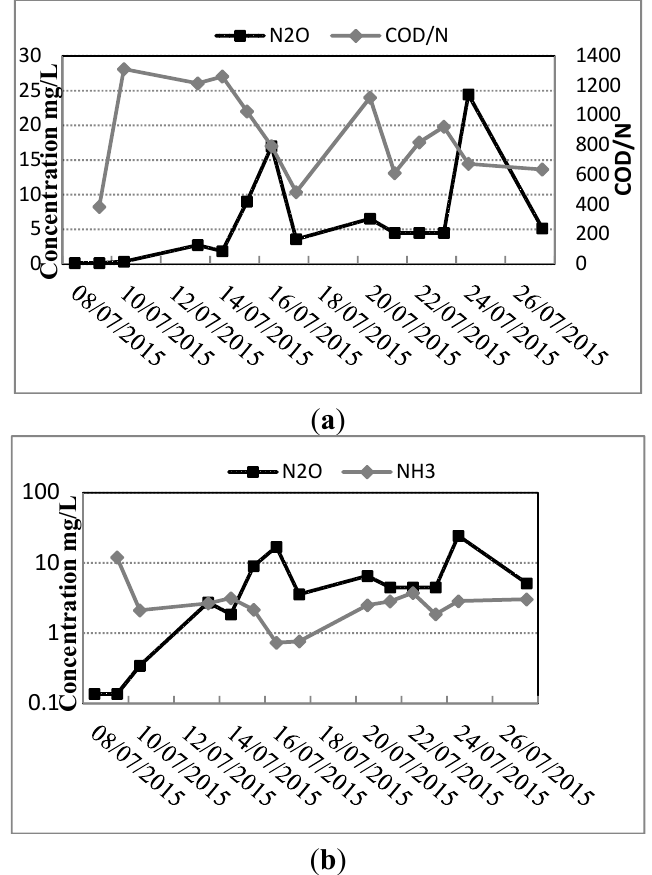
Figure 7. ( a ) N 2 O concentration in the off-gas of the aerobic digester and COD/N ration in the reactor; ( b ) N 2 O concentration in the off-gas of the aerobic digester and NH 3 concentration in the